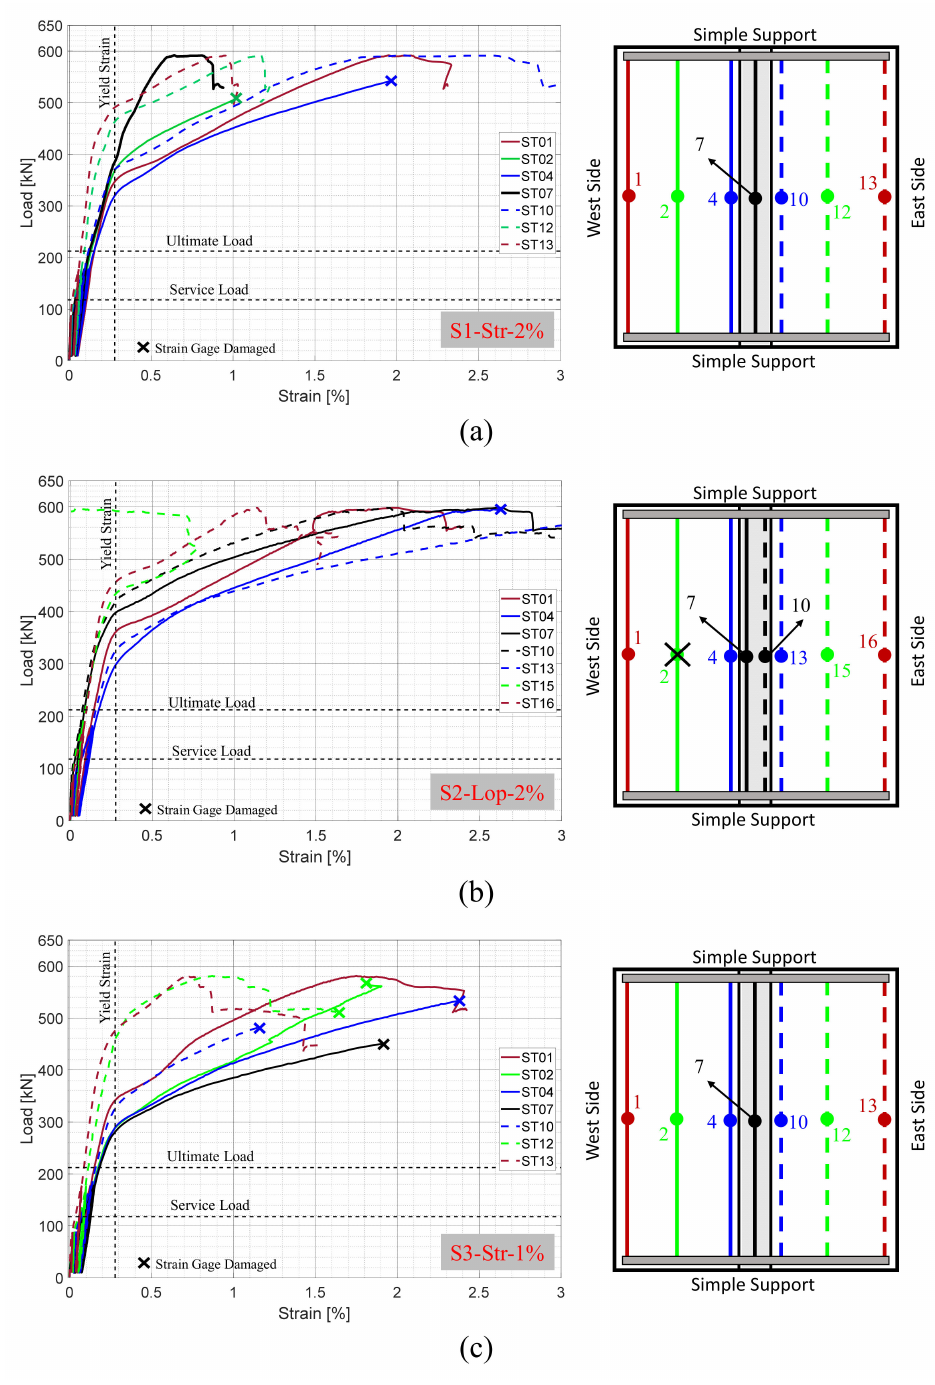
Figure 9. Load versus tensile strains of the bottom transverse reinforcement measured at mid-span of specimens ( a ) S1-Str-2%; ( b ) S2-Lop-2%; ( c )